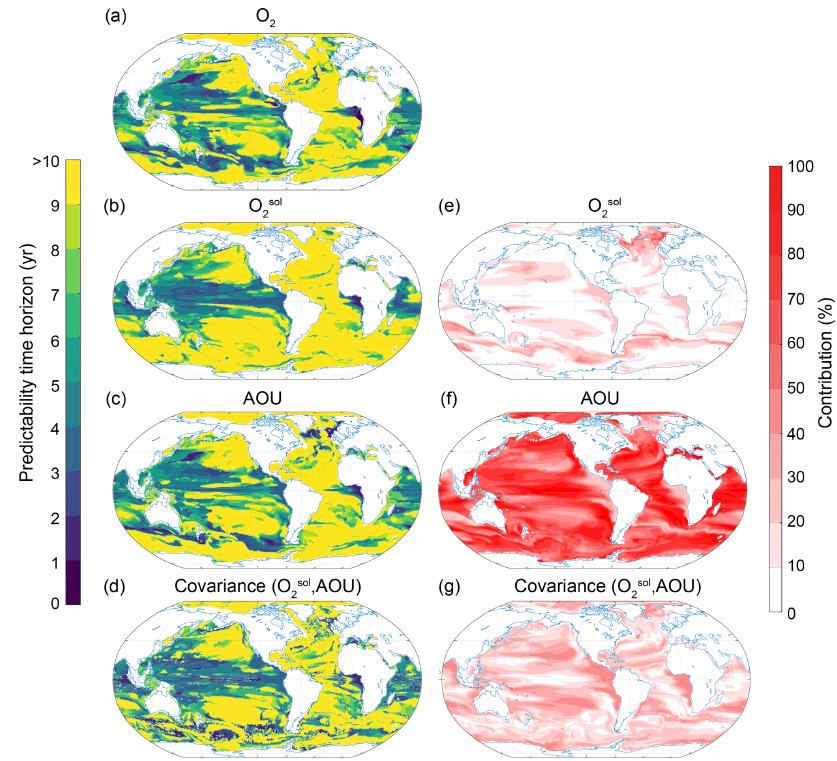
Figure 8. Same as Fig. 7, but at 300m